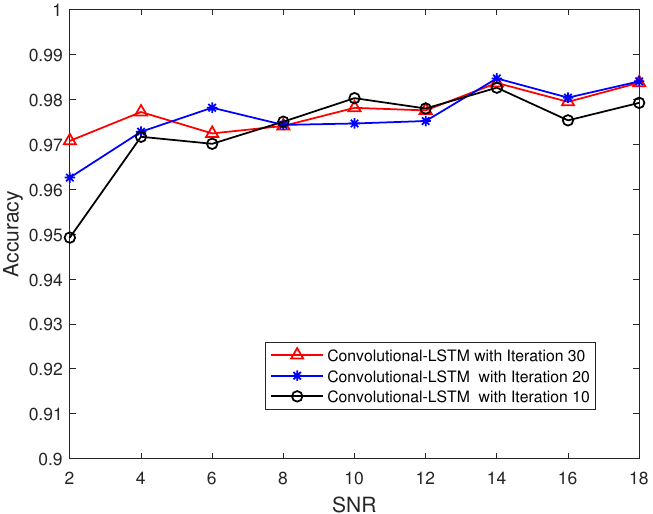
Figure 10. Performance comparison—SNR changes from 2 dB to 18